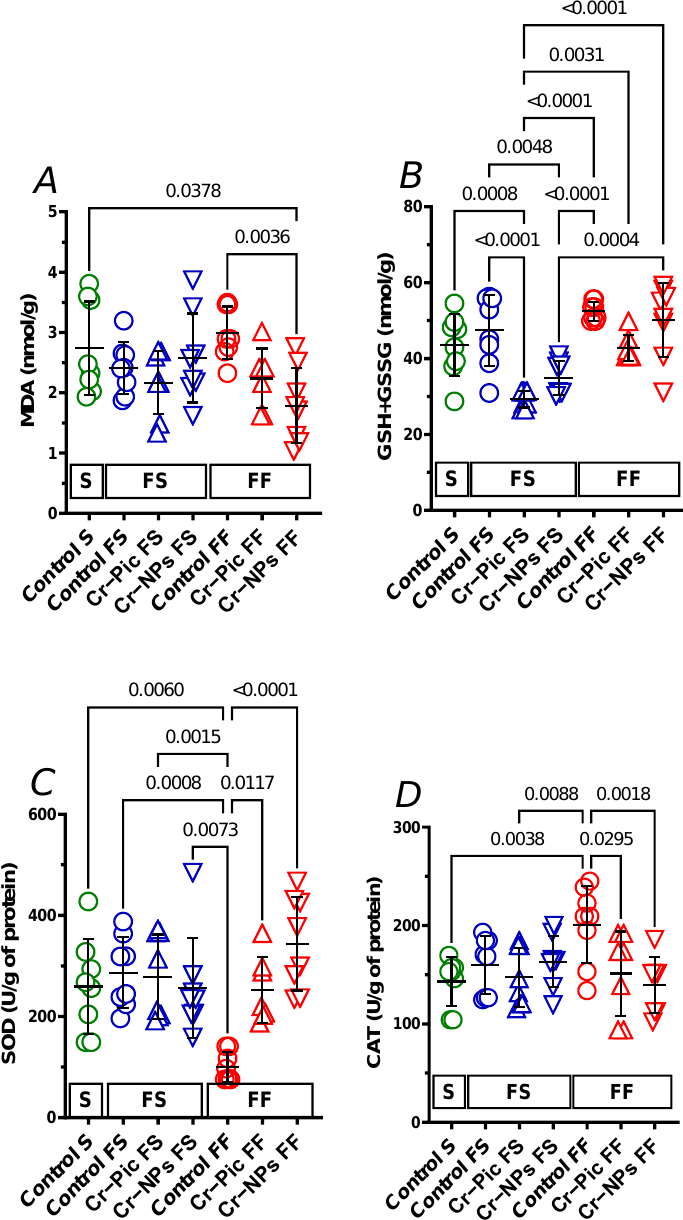
Figure 3. Heart MDA ( A ), GSH+GSSG ( B ), SOD ( C ) and CAT ( D ) of either chromium (Cr)-supplemented (9 weeks of supplementation) or nonsupplemented (Control S, Control FS, and Control FF) rats. 0.3 mg Cr/kg of body weight as chromium picolinate (Cr–Pic) or chromium nanoparticles (Cr–NPs) were added after the initial 9 weeks of experimental feed without Cr supplementation. Two types of diet were applied: a standard-fat-and-fiber (S) diet and a high-fat–low-fiber (F) diet. Rats at 7 weeks of age were fed with an S diet or an F diet for either 9 weeks or 9 + 9 weeks. The following groups of rats were studied: Control S, the S diet plus the S diet; Control FS, the F diet and the S diet; Cr–Pic FS, the F diet and the Cr–Pic S diet; Cr–NPs FS, the F diet and the Cr–NPs S diet; Control FF, the F diet and the F diet; Cr–Pic FF, the F diet and the Cr–Pic F diet; Cr–NPs FF, the F diet and the Cr–NPs F diet. Values are means ± SD, n = 8, p ≤ 0.05 (two-way ANOVA/Tukey’s multiple comparisons test). In rats fed with the F diet for 9 weeks, Cr–NPs and Cr–Pic decreased the GSH+GSSG. In rats fed with F diet for 18 weeks Cr–NPs decreased both the MDA and CAT and increased SOD; meanwhile, Cr–Pic decreased CAT and increased SOD. No significant difference between Cr–NPs and Cr–Pic was observed in MDA, GSH+GSSG, SOD, and CAT. Abbreviations: CAT, catalase; GSH+GSSG, total glutathione; MDA, malondialdehyde; SOD, superoxide